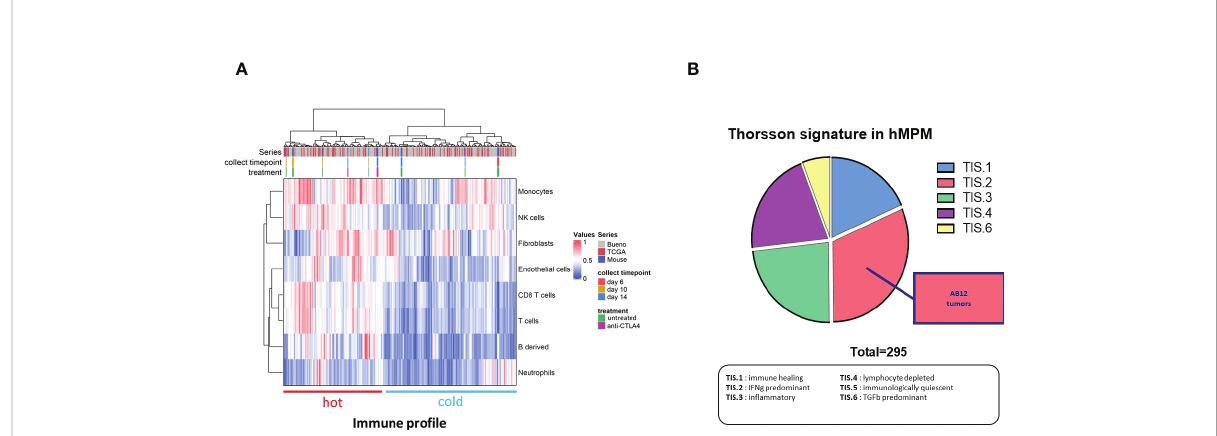
FIGURE 5 Immune features of AB12 tumors in comparison to hMPM. (A) Integration based on immune and stromal cells in fi ltrations of AB12 tumors in hMPM tumors. Unsupervised clustering of untreated and anti CTLA-4 treated AB12 tumors with 295 hMPM tumor samples was performed based on the in fi ltrations of immune and stromal cell populations. The series of each tumor sample, the collect timepoint and the treatment of AB12 tumors are indicated by a color code at the top of the heatmap. At the bottom of the heatmap, clusters were divided into tumors with a “ hot ” and “ cold ” immune pro fi les based on immune cells in fi ltration. (B) Thorsson immune classi fi cation. Thorsson immune subtypes (TIS) were determined in the 295 hMPM and in AB12 tumor samples using TIS transcriptomic signatures. Tumor samples were classi fi ed in one of the TIS based on the highest signature score.